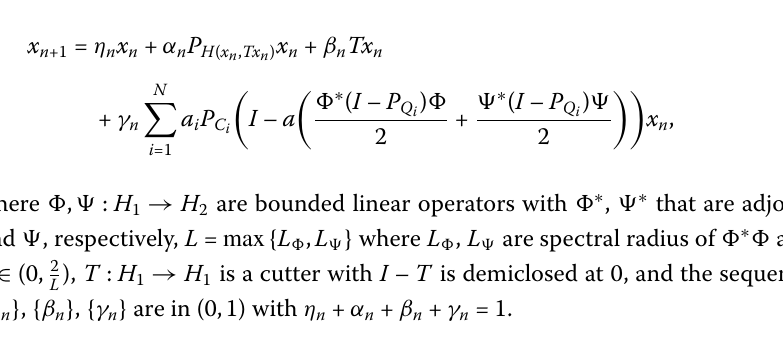
Algorithm 1.1 Given x 1 ∈ H 1 and let the sequence { x n } be define